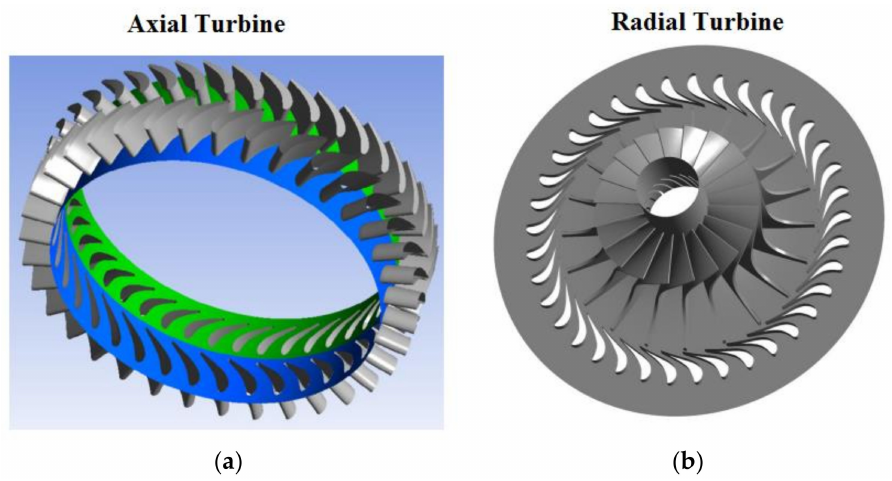
Figure 9. 3D geometries of ( a ) axial turbine [164], and ( b ) radial turbine